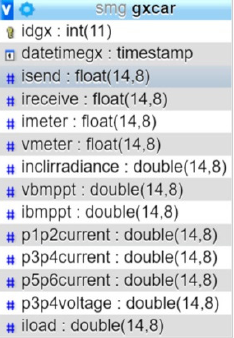
Figure 4. Flowchart of operations performed by the curve tracer.